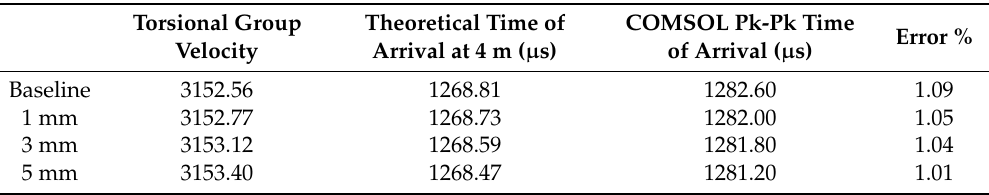
Table 3. Comparison of theoretical and FEA Time of